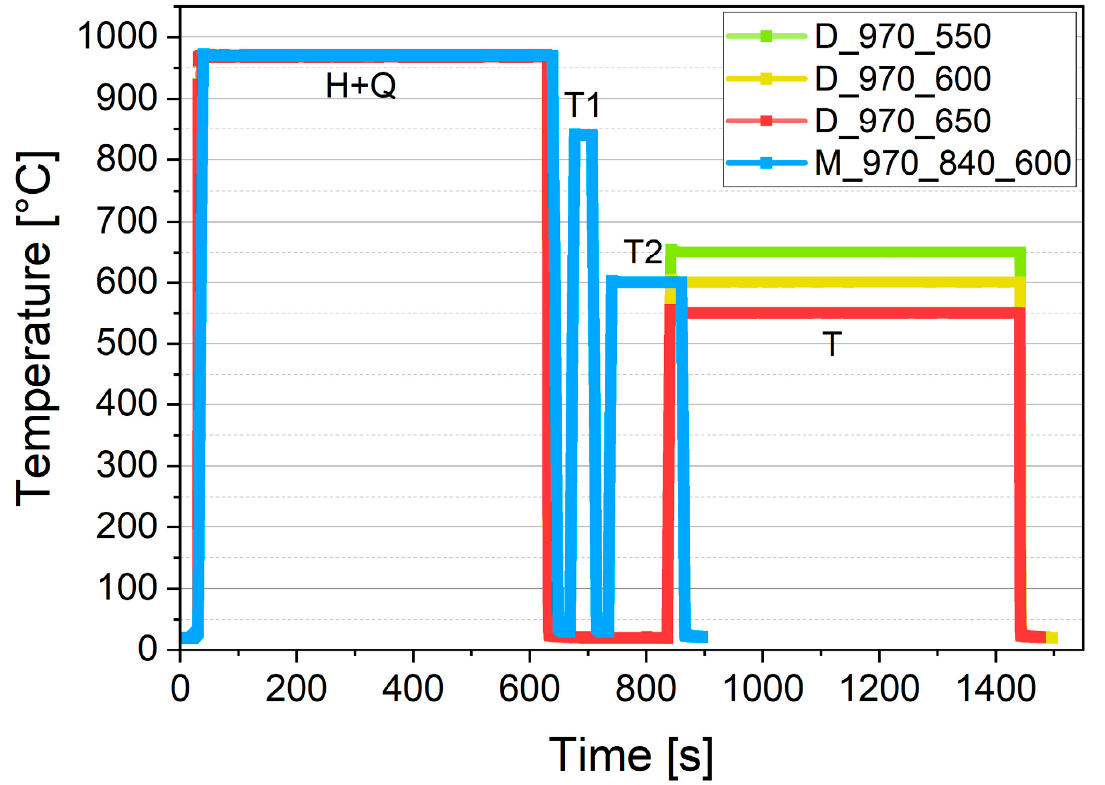
Figure 1. Temperature-time-profile of homogenized and reheated samples (D_970_550-650) as well as homogenized, martensite-free samples and reheated sample (M_970_840_600). Table 2. Heat treatment schedule consisting of homogenization and reheating to service temperatures as well as high-temperature tempering and reheating to service temperatures.